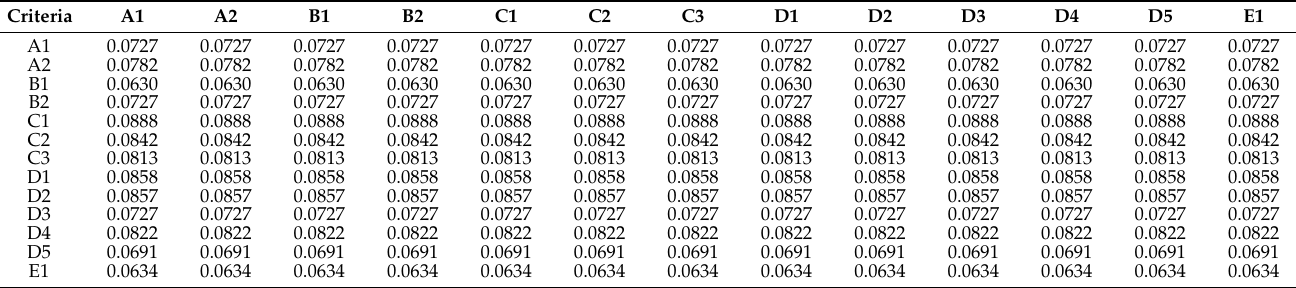
Table 8. Ultimate super matrix established according to the criteria.